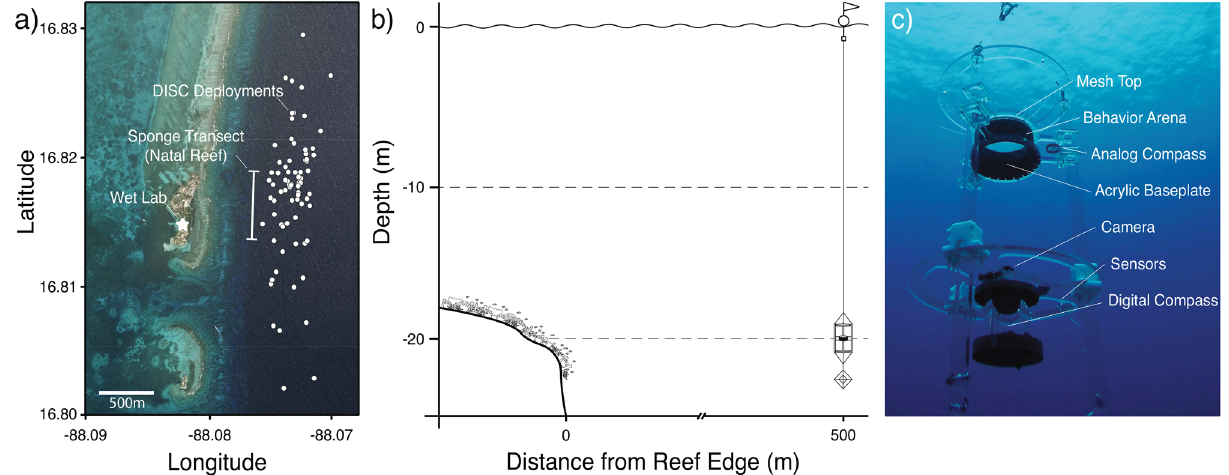
Figure 2. Methods for testing the swimming and orientation behavior of Elacatinus lori larvae. ( a ) Position of Drifting In Situ Chamber (DISC) deployments offshore from Southwater Caye, Belize. Satellite imagery was obtained from an ArcGIS Online basemap 87 . ( b ) A single larva was deployed in the DISC at 19 m depth in open water within 500 m of their natal reef. ( c ) Image of the DISC configured for assessing the behavior of E. lori larvae. Star—International Zoological Expeditions field lab. Bar—sponge transect where larvae were collected (i.e., their natal reef). White Dots—starting location of deployments ( n =